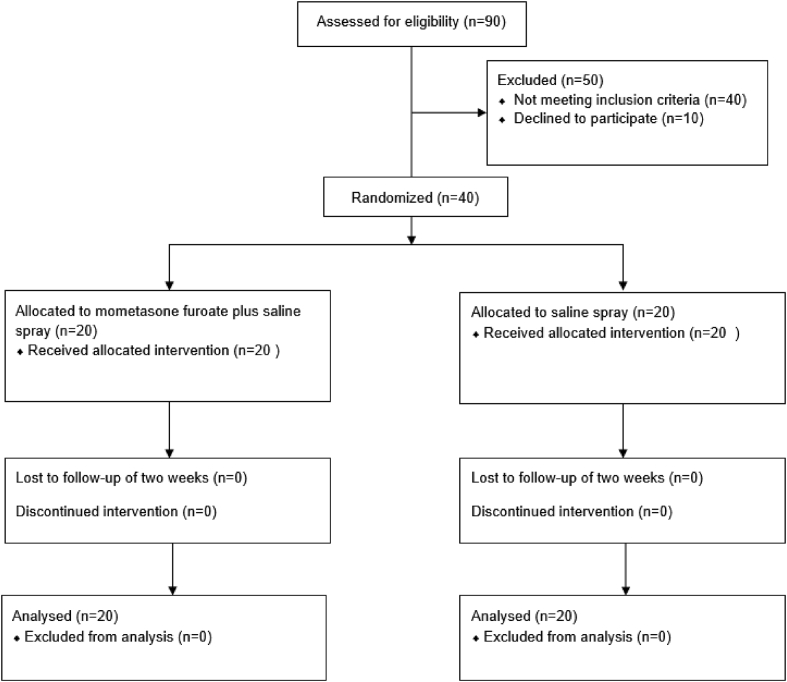
Trial flow chart